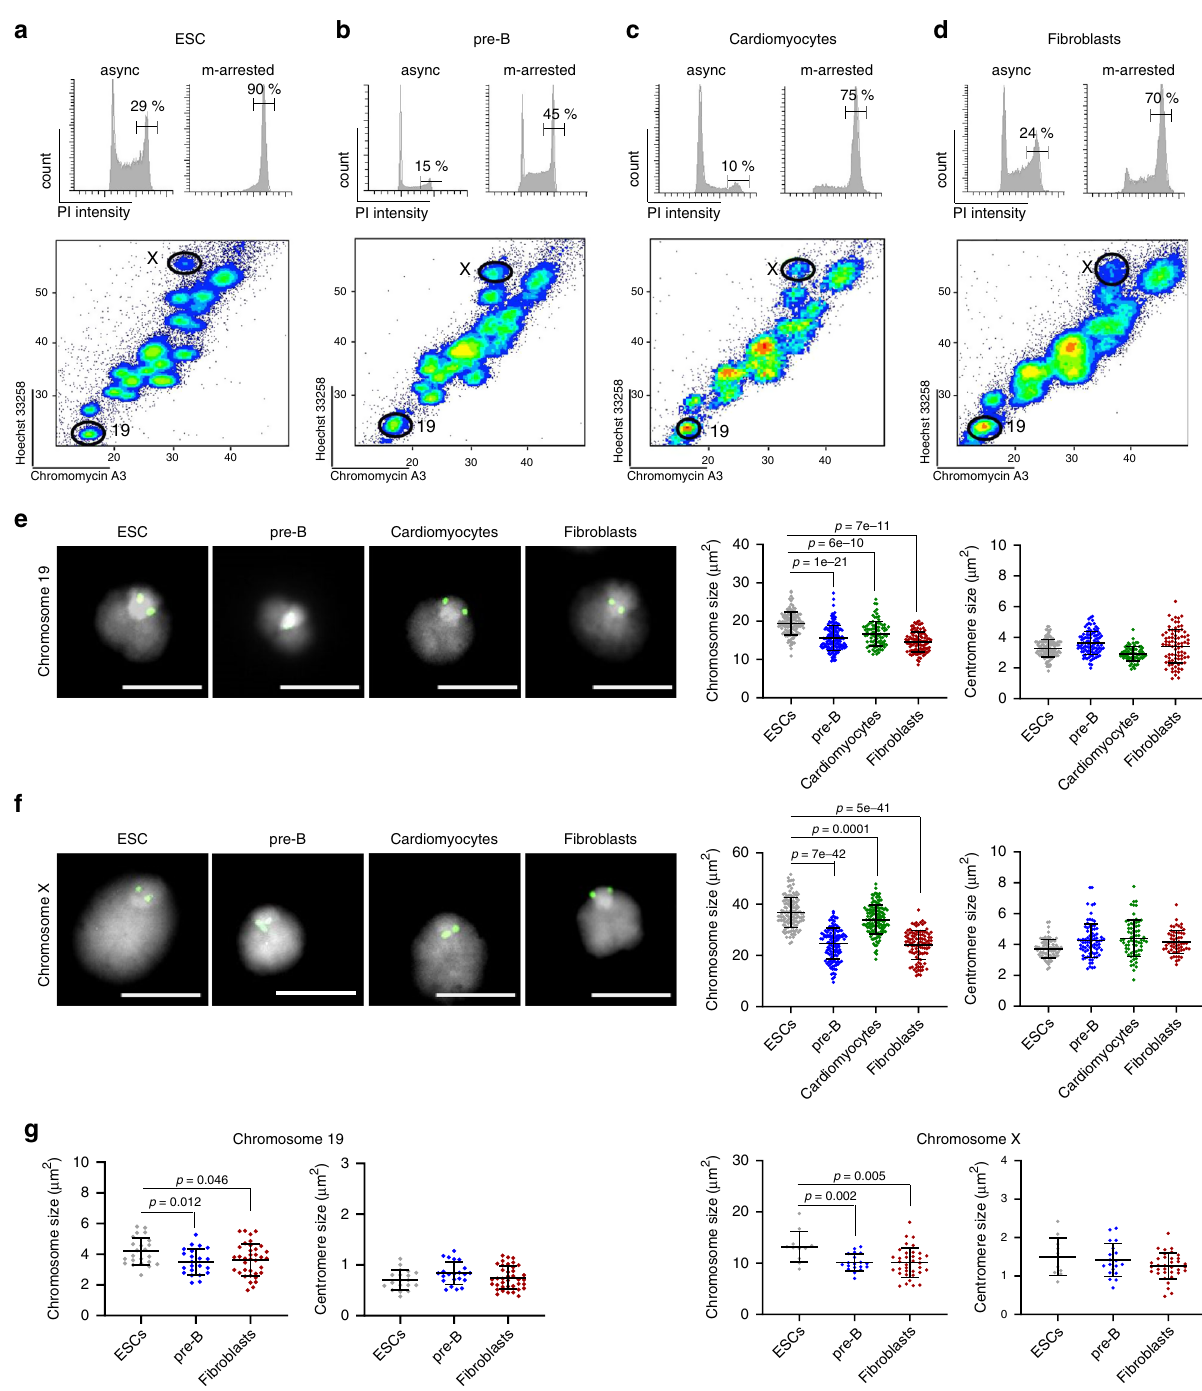
Fig. 4 Native mitotic ESC chromosomes are larger than equivalents isolated from differentiated cells. a – d Cell cycle pro fi les of mouse ESCs ( a ), pre-B cells ( b ), cardiomyocytes ( c ) and embryonic fi broblasts ( d ) were determined by staining with propidium iodide. Left panel shows asynchronized (async) cells, right panel shows samples 6 – 12h after treatment with demecolcine (m-arrested), where values indicate the percentage cells in G2/M stage. Lower panel shows fl ow karyotype of demecolcine-treated cells and the gates used to isolate chromosomes 19 and X. Images are representative of three independent experiments. e , f Representative images of native mitotic chromosomes 19 ( e ) and X ( f ) isolated from mouse ESCs, pre-B cells, cardiomyocytes (HL-1) and embryonic fi broblasts. DAPI stain (light grey) and Cenpa (green) labelling are shown, scale bars = 5 μ m. Chromosome and centromere sizes were determined for each cell type by measuring individual chromosomes (chromosome 19: n = 137, 149, 88 and 106; chromosome X: n = 129, 132, 134 and 103) and centromeres (chromosome 19: n = 119, 100, 72 and 83; chromosome X: n = 81, 81, 70 and 60) over three independent experiments, mean± SD are indicated. g Chromosome and centromere sizes of chromosome 19 (left panel) and chromosome X (right panel) were calculated by measuring metaphase spreads of ESCs ( n = 23), pre-B cells ( n = 22) and embryonic fi broblasts ( n = 36), mean ±SD are indicated. e – g P -values of statistically signi fi cant decreases, measured by unpaired two tailed Student ’ s t -tests, are indicated. Source data are provided as a Source data fi